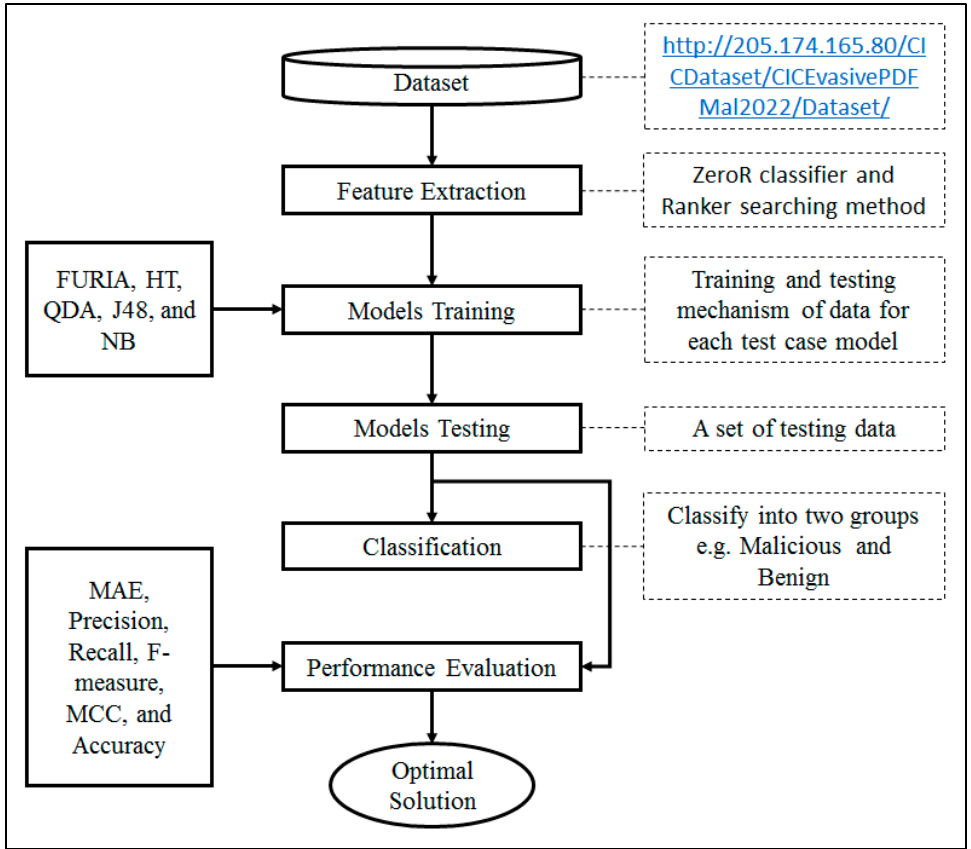
Figure 1. Methodology workflow [22].